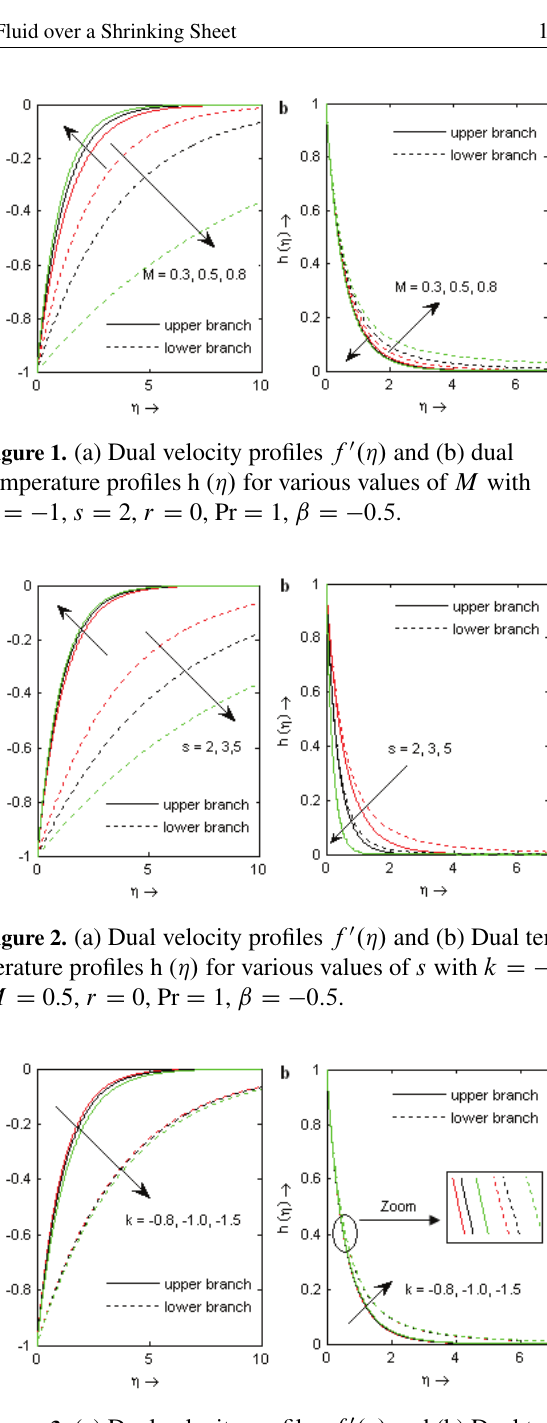
the value of r also increases the temperature profiles and makes the thermal boundary layer thicker. Finally, the in- fluence of the heat absorption parameter ˇ on temperature the temperature profiles decreases with increasing the sink strength ( ˇ